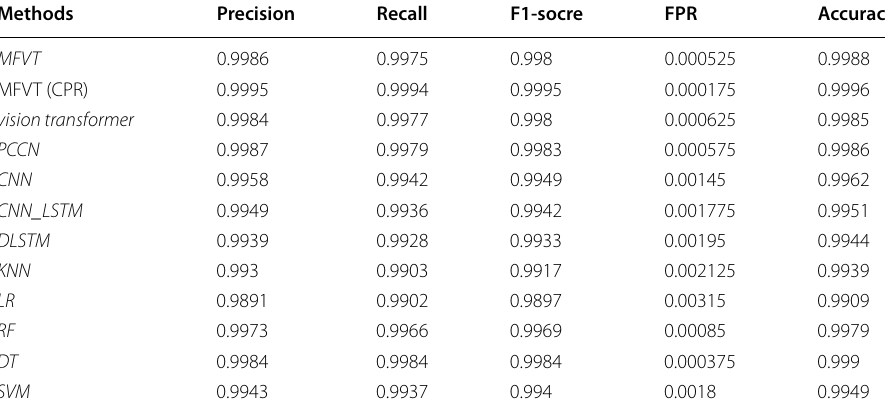
Table 3 Experimental results on the 2012 dataset